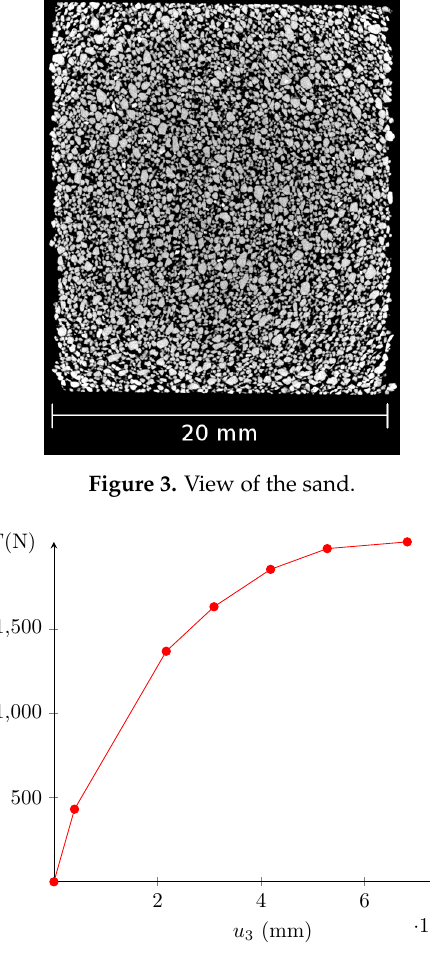
Figure 4. Measured top